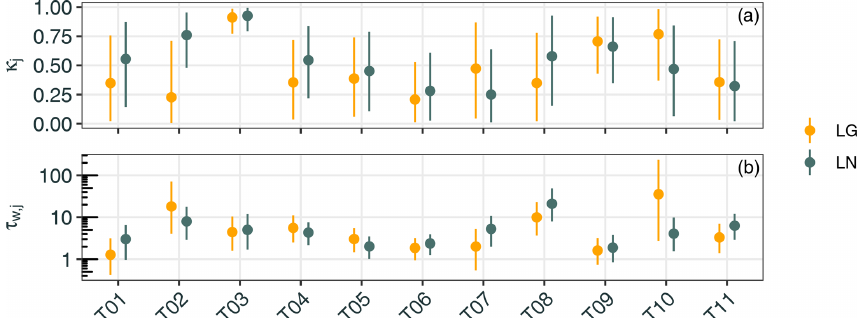
Figure 6. Posterior means and 95% credible intervals for κ (a) and τ w ( b , shown using a log scale), for the 11 land regions: TransCom3 region 01 (T01) to TransCom3 region 11 (T11). Estimates are shown for inversions using LG data (yellow) and LN data (dark green).